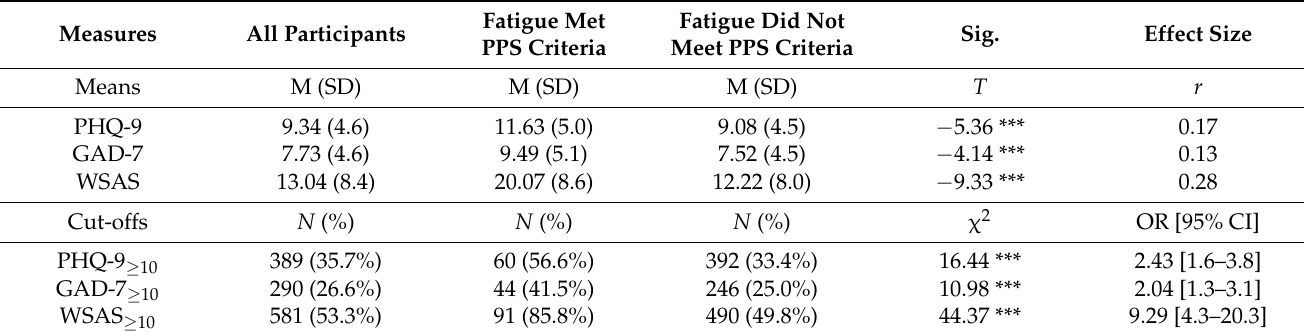
Table 2. Comparison of depressive symptoms, anxiety symptoms and functional impairment between participants whose fatigue met or did not meet PPS